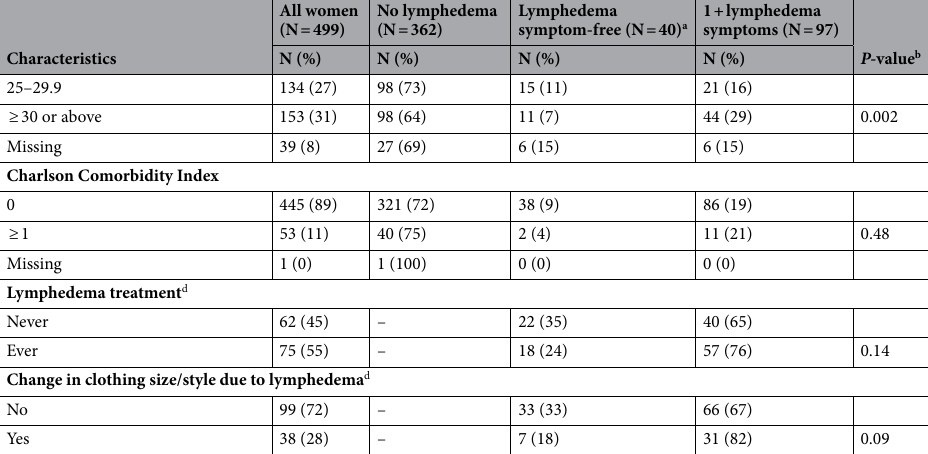
Table 1. Characteristics of 499 HEAL women. MET metabolic equivalents of energy expenditure, N number. a One of the 98 women reporting current lymphedema at the 40-month assessment did not report any of the lymphedema-related symptoms we queried; this woman is included in the “Lymphedema symptom-free” group. b P -values are based on Chi-square test without missing values. c A statistically significant difference was detected based on Chi-square test comparing between women who were lymphedema symptom-free and women with 1 or more lymphedema symptoms ( P < 0.05). d The proportions are based on 137 women who reported past or current